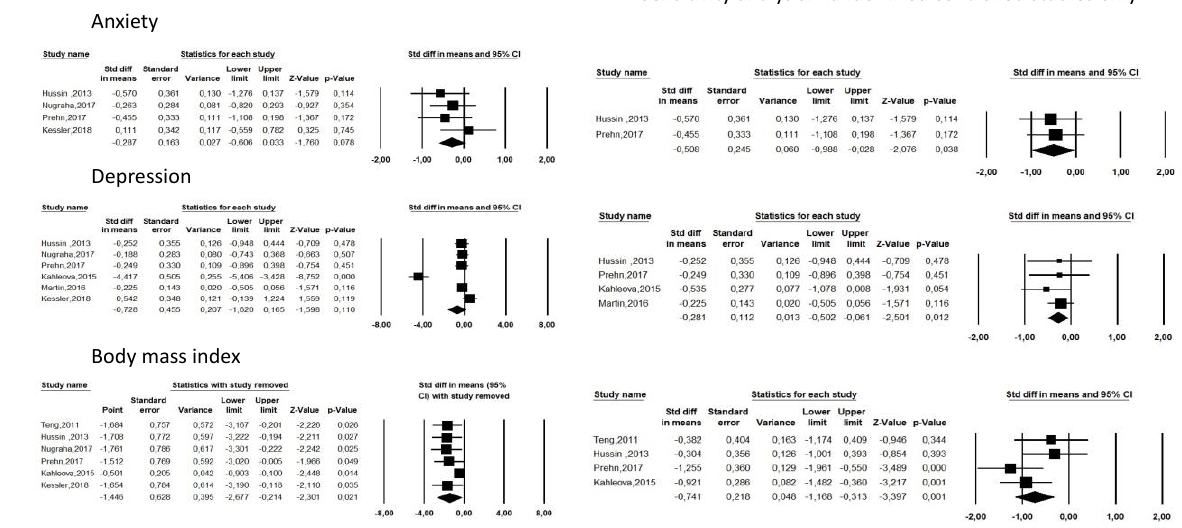
Figure 3. Forest plots of fasting intervention controlled studies for anxiety, depression and body mass index.